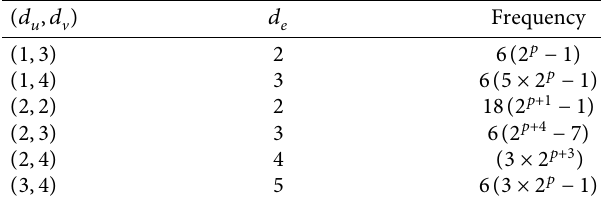
Table 1: Partition of the edges of D